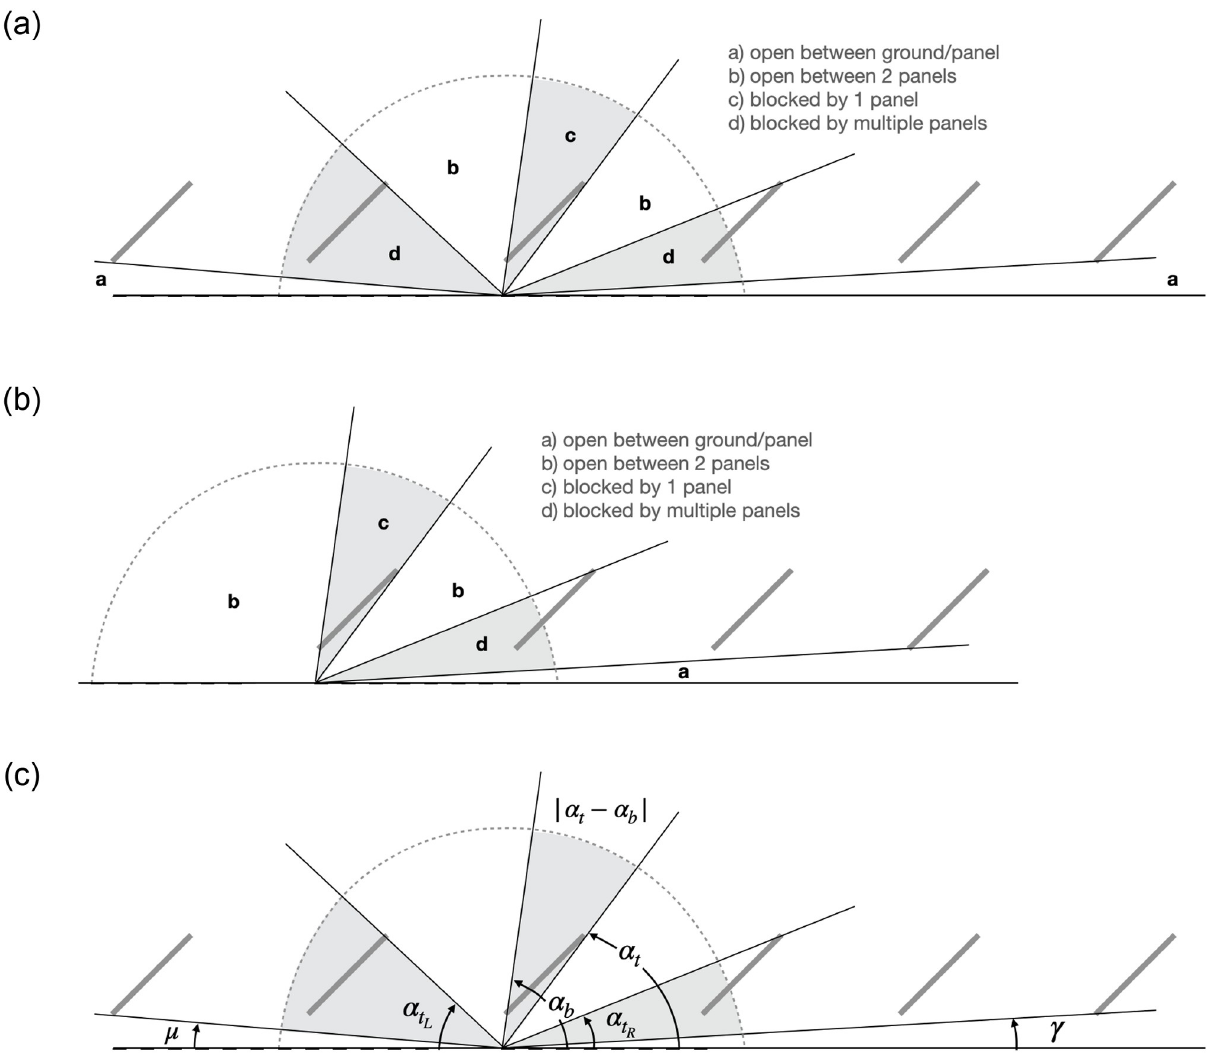
Fig 6. a. Wedges used to determine viewfactor. b. Wedges used to determine viewfactor in left edge cases. c. Angles used to determine viewfactor, variables